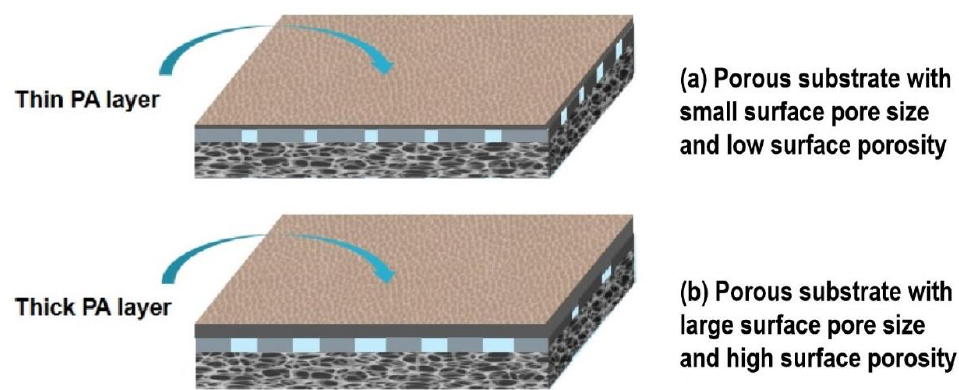
Figure 6. Schematic of PA layer formed on different porous substrates. ( a ) A substrate with small surface pore size and low surface porosity prefers to form a thin PA layer; ( b ) a substrate with large surface pore size and high porosity prefers to form a thick PA layer.